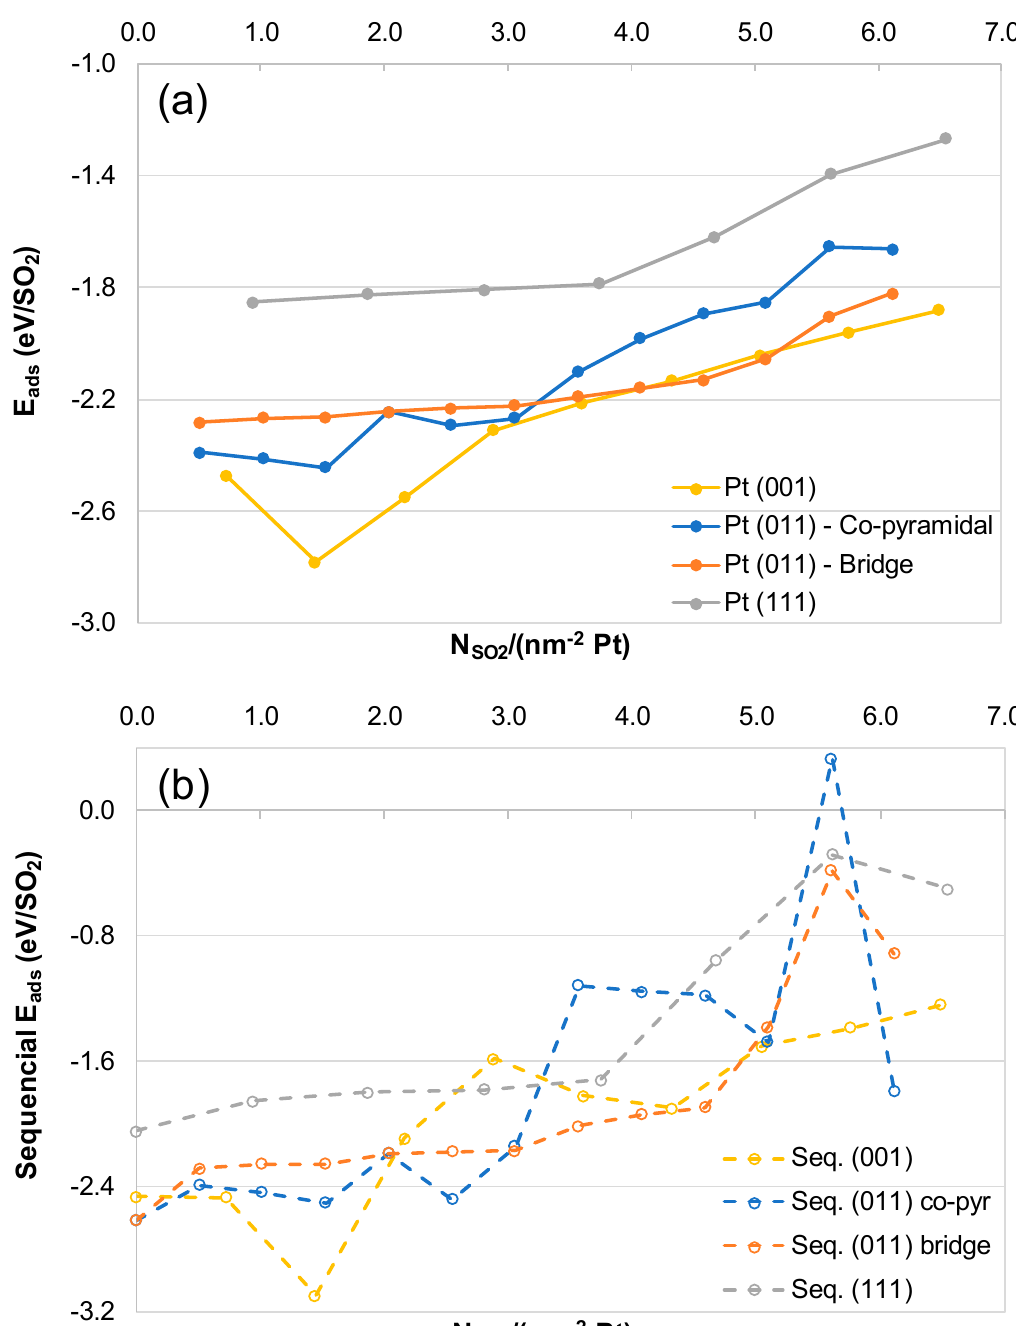
Figure 5. Average ( a ) and sequential ( b ) adsorption energies ( E ads ) as a function of the SO 2 surface coverage (nm − 2 Pt) on the Pt (001), (011), and (111) surfaces.